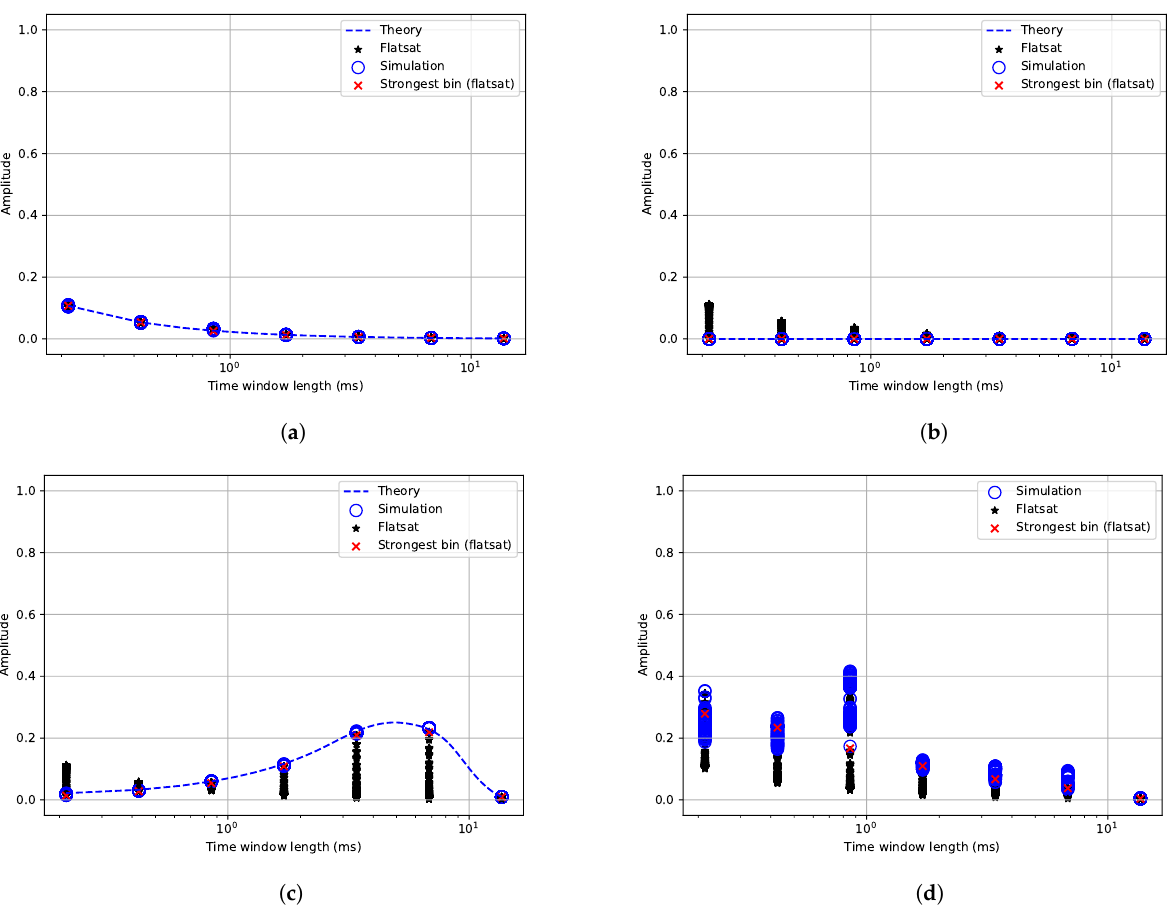
Figure 5. Comparison of bin difference in theory, simulations and measurements with the flatsat. The pulse and the chirp signal have a pulse length of 5 s and a period of 16.67 ms. ( a ) AWGN bin difference. ( b ) CW bin difference. ( c ) Complex pulse bin difference. ( d ) Complex chirp bin